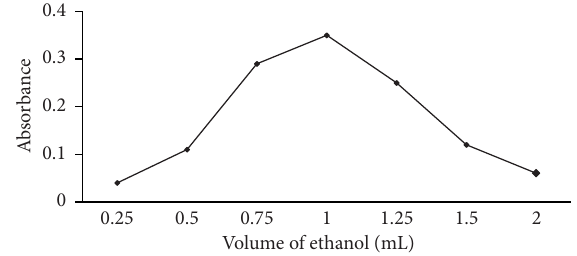
Figure 4: Effect of the disperser solvent volume on analyt- ical responses, Conditions: sample volume 5.0 mL containing 1.0ngmL −1 Zn(II), extraction solvent 200 𝜇 L CCl 4 containing 2.5 × 10 −6 molL −1 PPT, extraction time 10min.